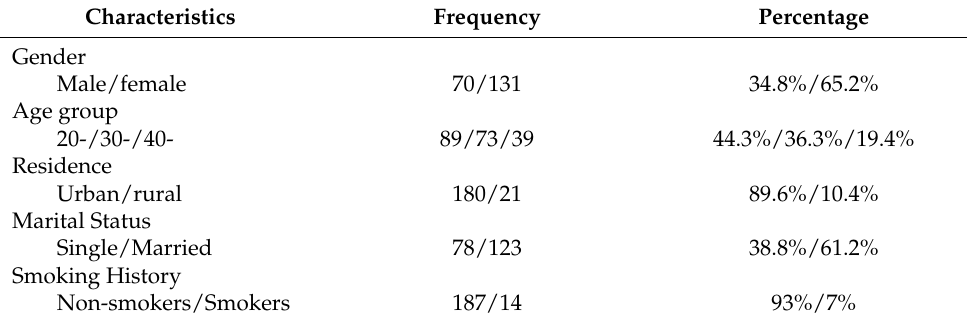
Table 1. Sociodemographic Characteristics of cohort Doctors.